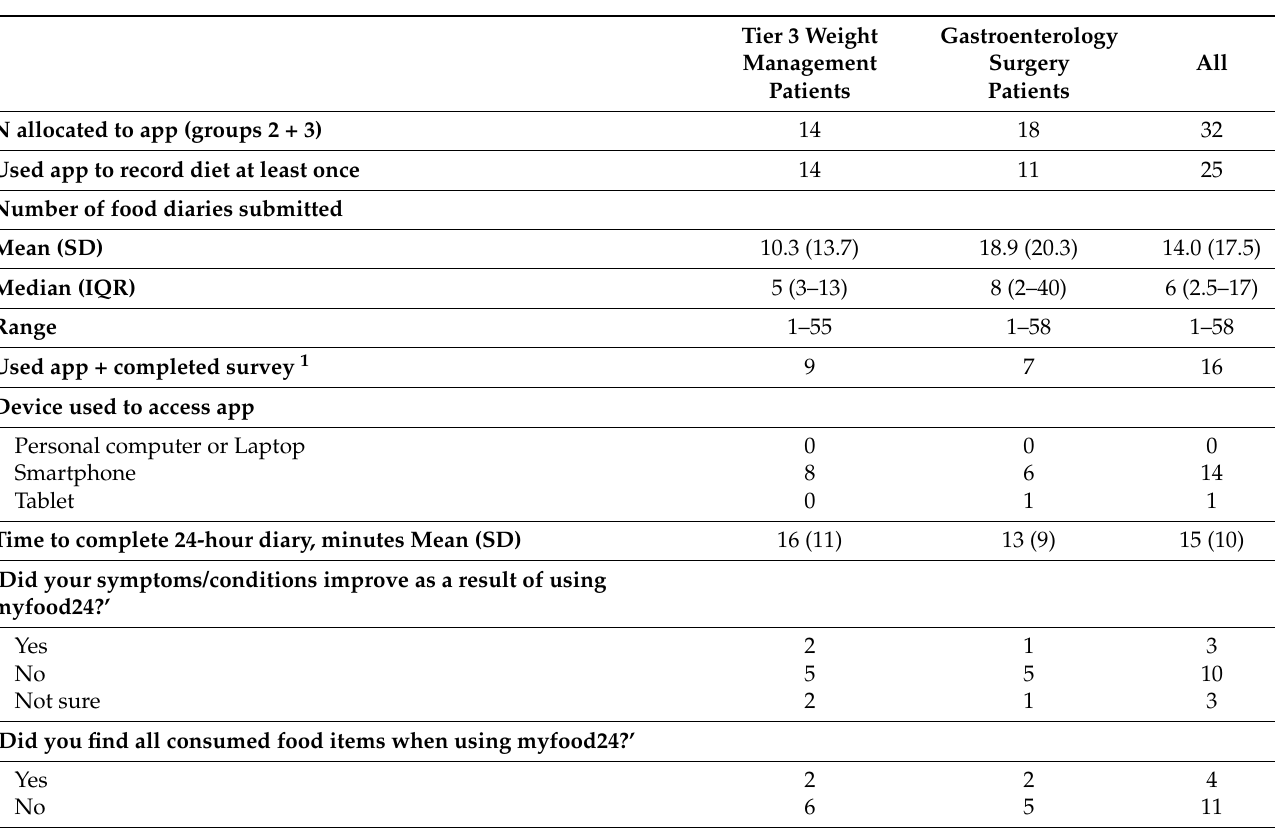
Table 4. myfood24 use and usability score in those using the app responding to the